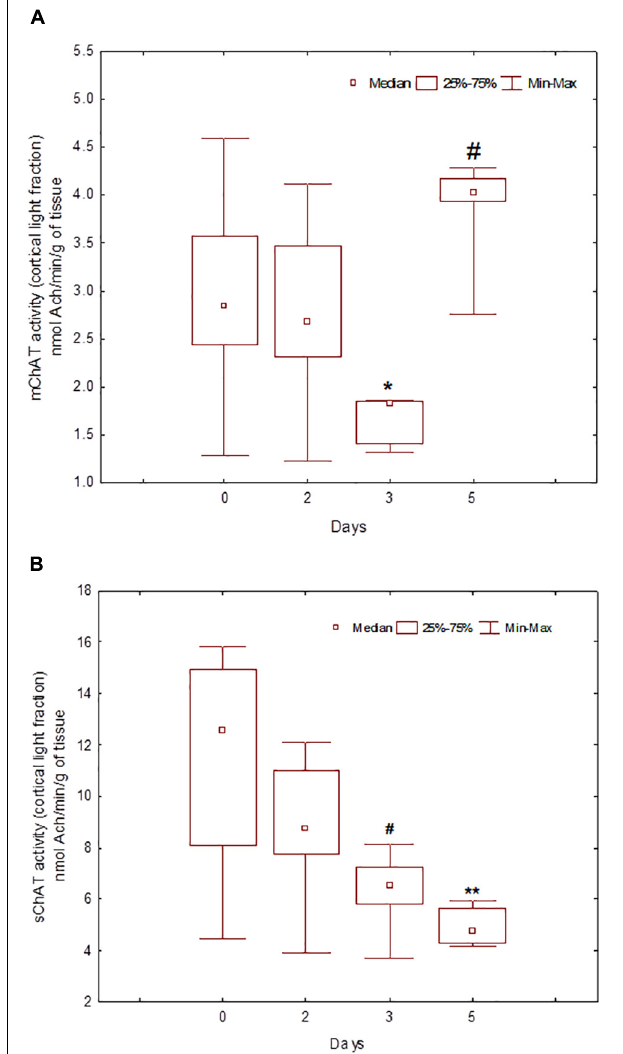
FIGURE 5 | Choline acetyltransferase (ChAT) activity in light synaptosomal sub-fractions from the neocortex in naïve rats (day 0) and after 2, 3, or 5 days of training in the Morris water maze (MWM). The y -axis is the ChAT activity (nmoles ACh/min/g tissue). (A) mChAT from light synaptosomal fraction, (B) sChAT from light synaptosomal fraction, * p < 0.05 and ** p < 0.01 relative to naïve rats. # p < 0.05 relative to the previous time